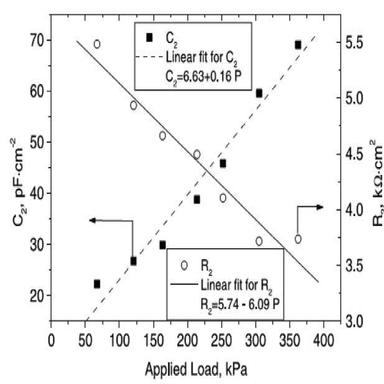
Dependence of circuit elements on applied load.